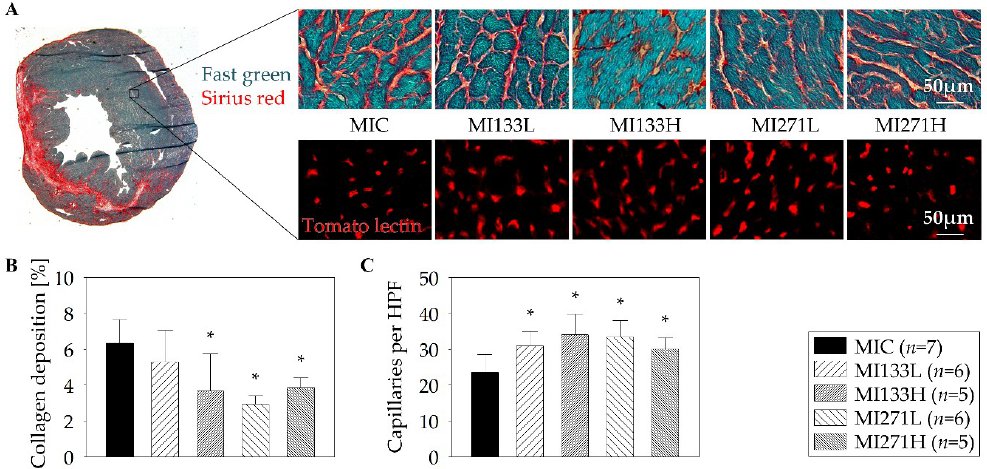
Figure 2. Cardiac remodeling three weeks post-myocardial infarction (MI). Histologically stained cross section of the infarcted heart as well as high-power fields (HPF) were performed to demonstrate degree of the fibrosis and capillary density at the remote area ( A ). No significant differences between the dose‐dependent stem cell treatments with regard to fibrosis ( B ) and capillary density ( C ) were observed. Mean±SD; * P ≤ 0.05 vs. MIC (Mann–Whitney U test).